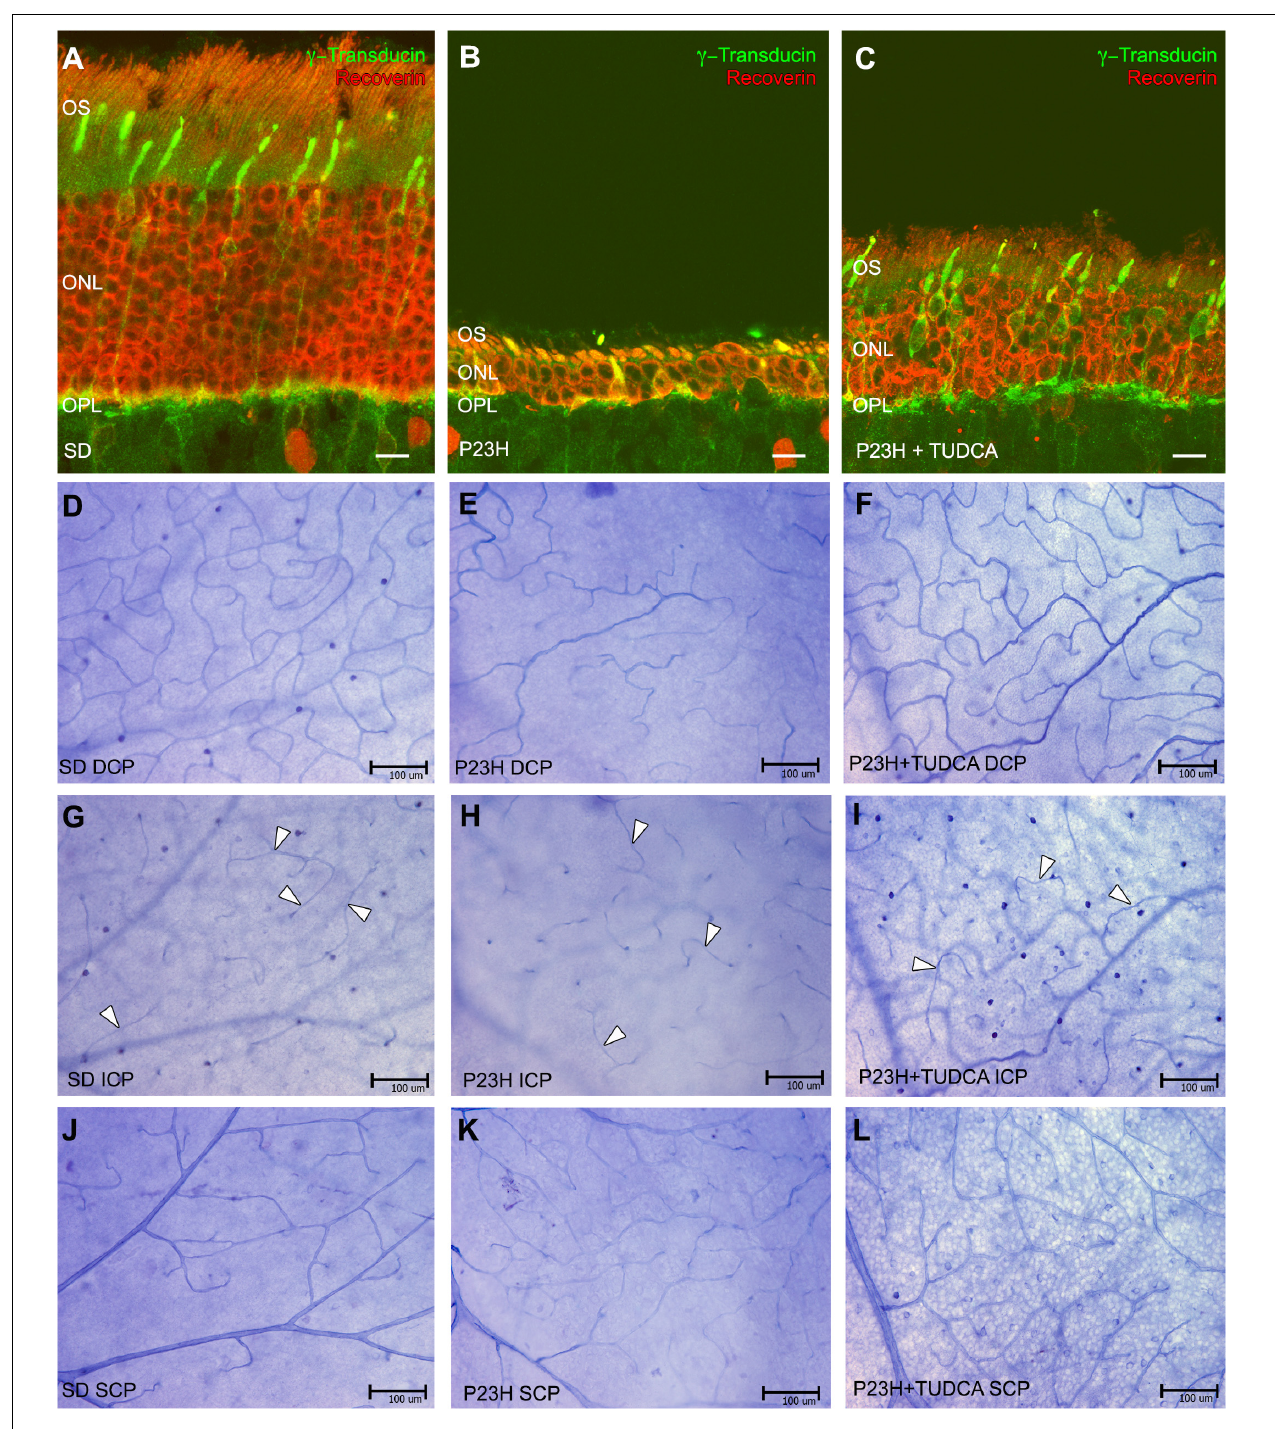
FIGURE 1 | Tauroursodeoxicholic acid (TUDCA) effects on vascular changes associated with photoreceptor death. (A–C) Retinal cross-sections stained with antibodies against recoverin (red) and γ -transducin (green) in a Sprague-Dawley rat (SD) (A) , P23H (B) , and TUDCA-treated P23H (C) rat at postnatal day (P) 120. (D–L) Whole mount retinas from an SD (D,G,J) , P23H (E,H,K) , and TUDCA-treated P23H (F,I,L) rat at P120 stained with Nicotinamide Adenine Dinucleotide Phosphate (NADPH) diaphorase. All images were taken from the medial areas of the retina avoiding the major blood vessels. P23H retinas showed an evident loss of photoreceptors (B) , accompanied by degenerated deep capillary plexus (DCP) (E) compared to SD animals (A,D) ; TUDCA was able to reduce these changes (C,F) . No differences between groups were observed at intermediate capillary plexus (ICP) (G–I) and superficial capillary plexus (SCP) (J–L) . Note that the ICP showed less dense but well-defined vessels (arrowheads) in all animals studied. OS, outer segments; ONL, outer nuclear layer; OPL, outer plexiform layer; DCP, deep capillary plexus; ICP, intermediated capillary plexus; SCP, superficial capillary plexus. Scale bars : 10 µ m (A–C) , 100 µ m (D–L) .